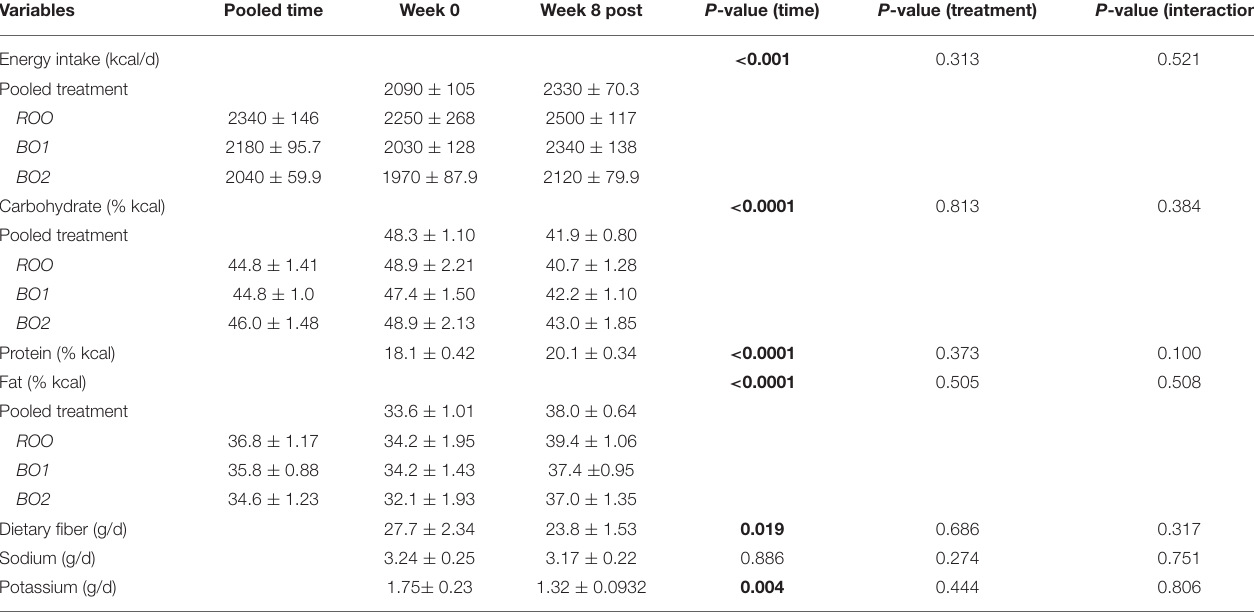
TABLE 3 | Nutrient data as mean ± standard error of the mean for the baseline and during intervention (week 8 post; which is the average of the post-baseline values) for each of the intervention groups in men, including only those who have completed the entire intervention ( N = 62; ROO = 21, BO1 = 23, BO2 = 18). Variables